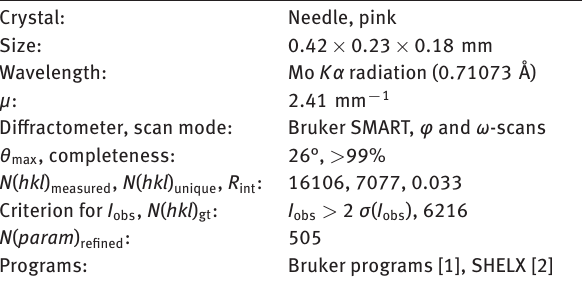
The asymmetric unit (without solvent water molecules) of the title crystal structure is shown in the figure. Tables 1 and 2 contain details on crystal structure and measurement condi- tions and a list of the atoms including atomic coordinates and displacement parameters. Table 1: Data collection and